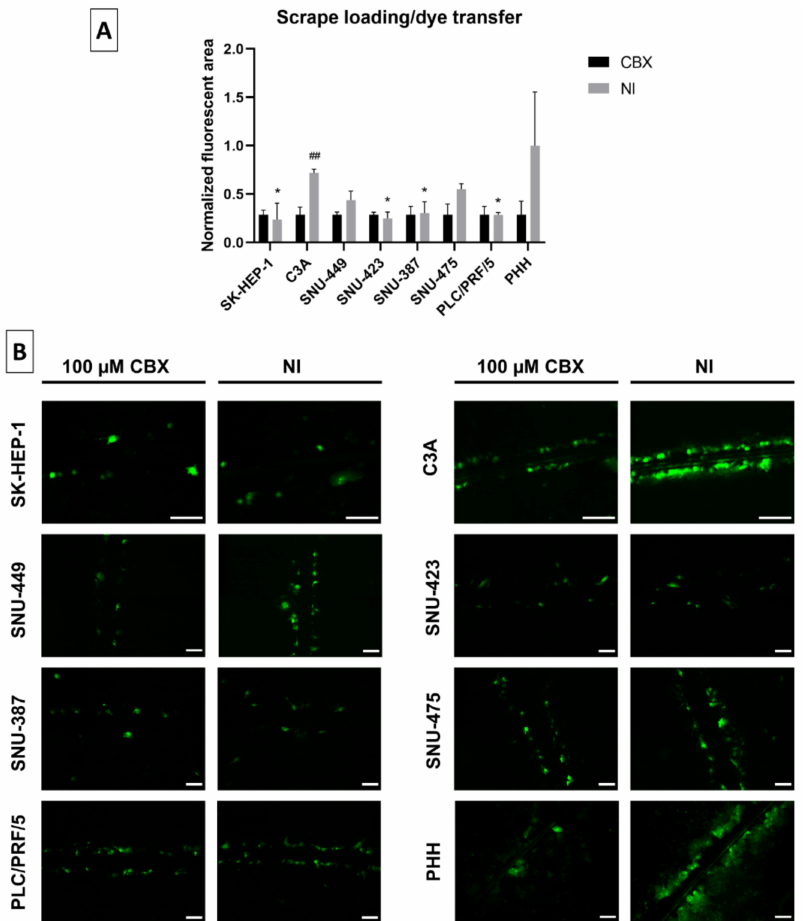
Figure 7. Gap junctional intercellular communication (GJIC) in liver cancer cell lines. All cell lines ( n = 1–2, N = 1 (multiple images per well)) were grown to 100% confluence when a scrape was made across the well in presence of Lucifer Yellow (LY). Cells were washed and subjected to fluorescence microscopy analysis. Images were taken with a 10 × or 20 × objective ( B ). GJIC was either not inhibited (NI) or inhibited by 100 µ M carbenoxolone disodium salt (CBX) for 10 min. The fluorescent area was measured with ImageJ. Data were normalized to the inhibited control and expressed as a ratio to the mean NI fluorescent area of primary human hepatocytes (PHH). Data are expressed as mean ± standard deviation ( A ). Significant differences compared to NI PHH are indicated with * p ≤ 0.05, while differences to the respective CBX control are indicated with ## p ≤ 0.01. Scale bar = 100 µ